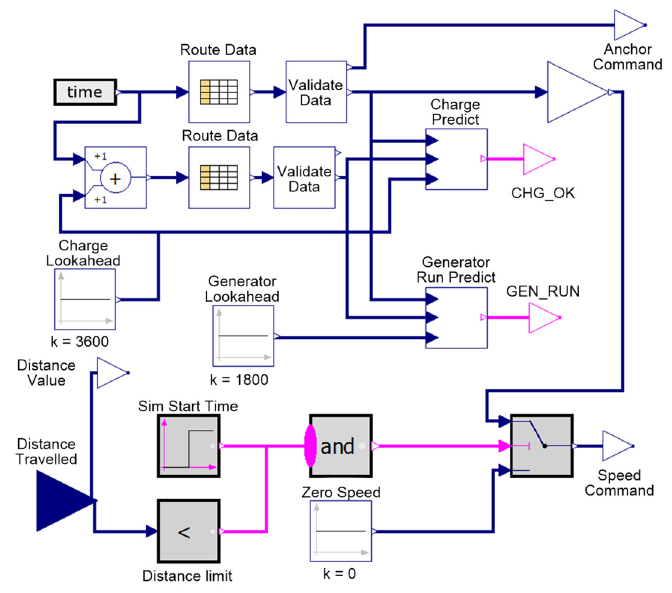
Figure 10. Passage route block.